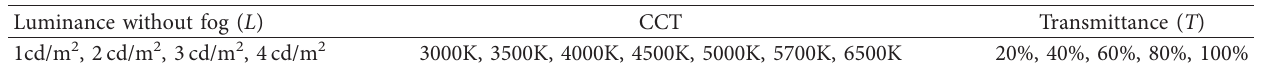
Figure 10: The calculation results of L Table 2: The values of each